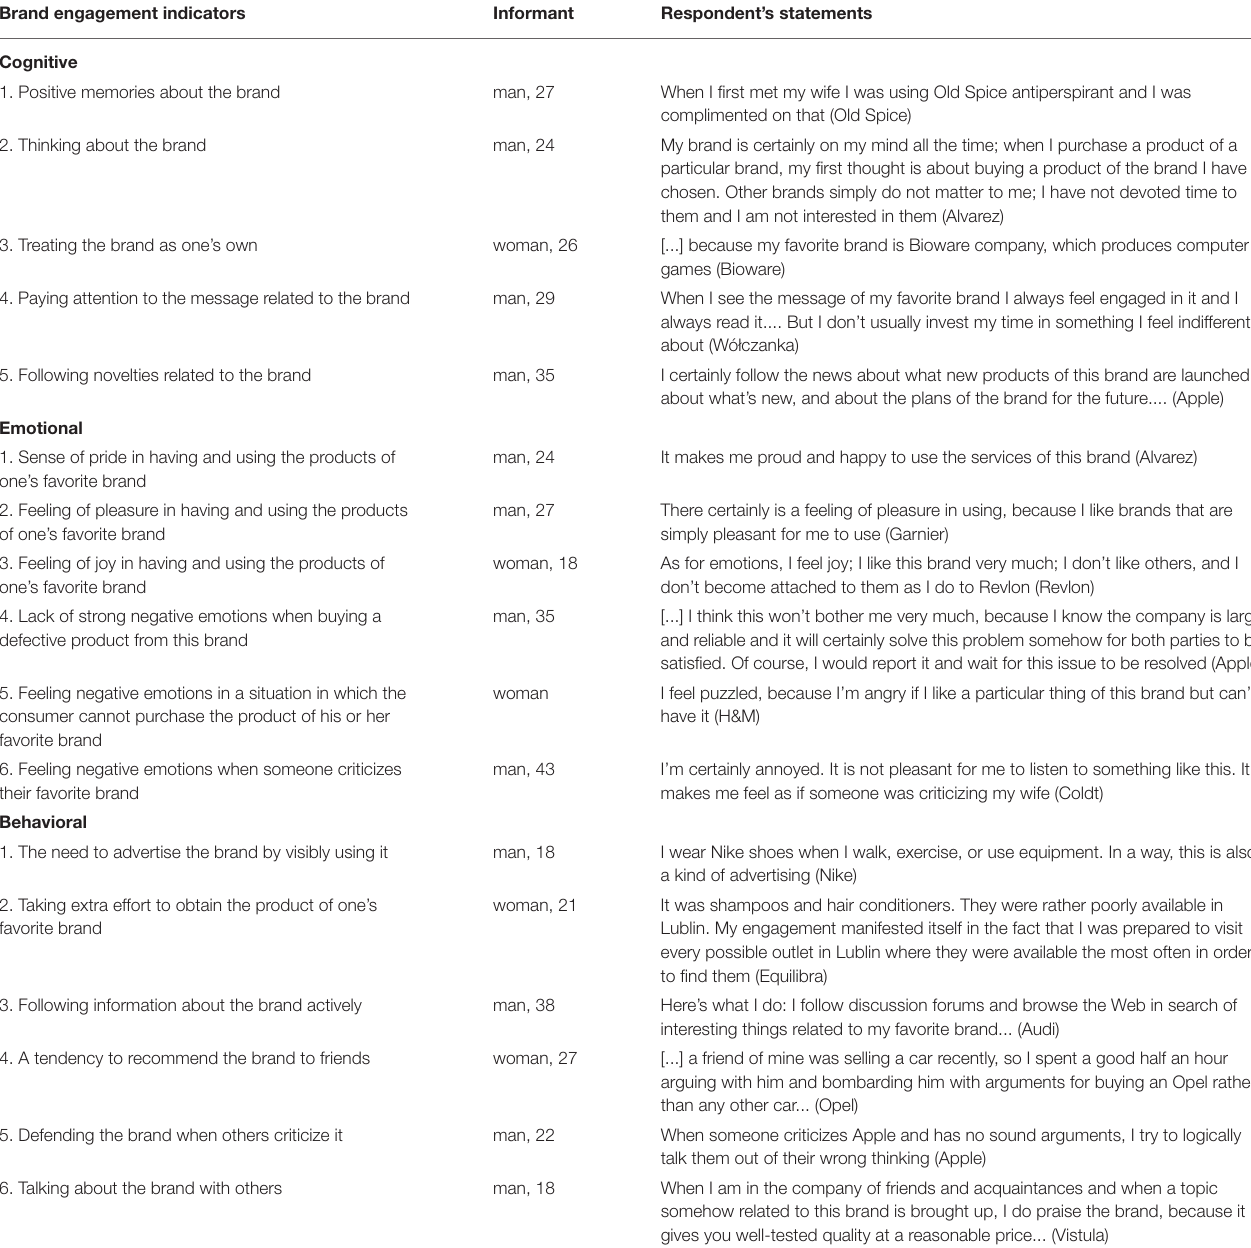
TABLE A1 | Brand engagement indicators and examples of consumer